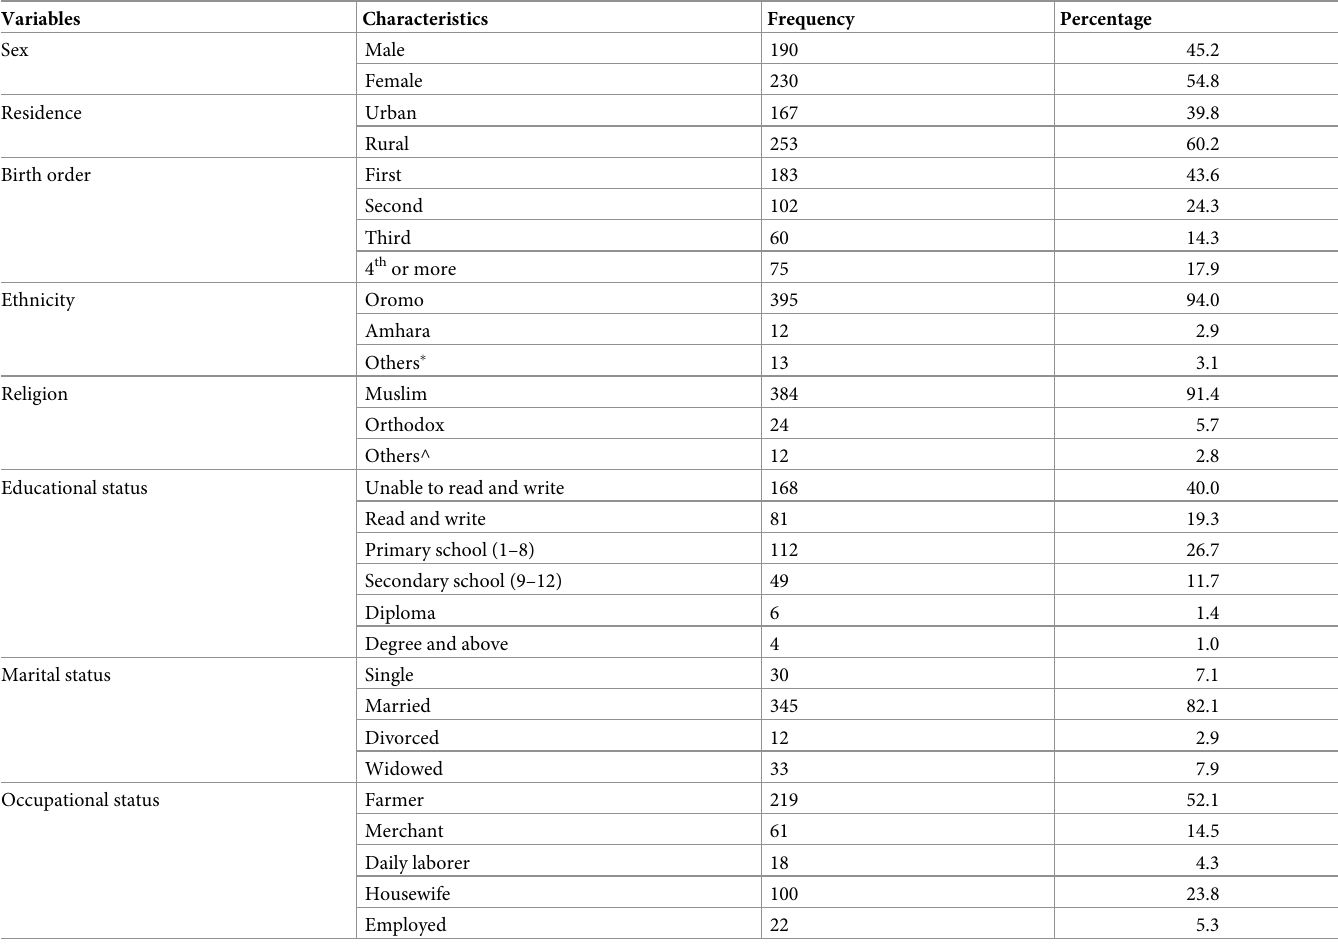
Table 1. Sociodemographic characteristics of respondents at Jimma Zone, Seka Chekorsa district Oromia, Ethiopia, March 2020.